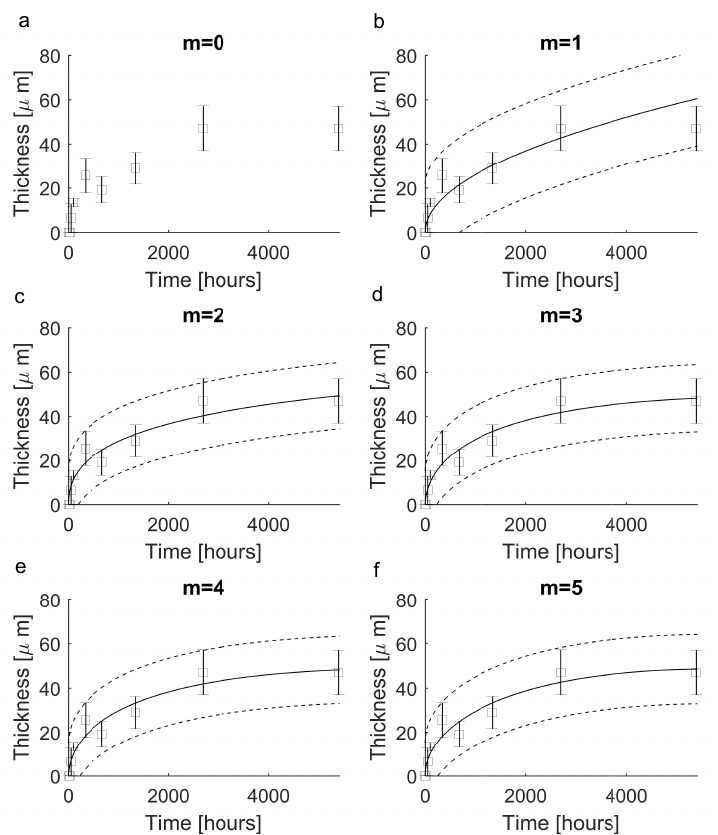
Figure 4. Reproduction of experimental data through the novel w n ( t ) functions (black squares = mean values, error bars = ± standard deviation, solid lines = theoretical predictions, dotted lines = 90% confidence prediction bounds). ( a ) The function w 0 ( t ) (m = 0) was unable to reproduce experimental values since it assumed a constant value. ( b ) The function w 1 ( t ) (m = 1) was able to reproduce experiments with R 2 = 0.8661. ( c ) The function w 2 ( t ) (m = 2) was able to reproduce experiments with R 2 = 0.9195. ( d ) The function w 3 ( t ) (m = 3) reproduced experiments with R 2 = 0.9197. ( e ) The function w 4 ( t ) (m = 4) reproduced experiments with R 2 = 0.9221. ( f ) The function w 5 ( t ) (m = 5) reproduced experimental data with R 2 =